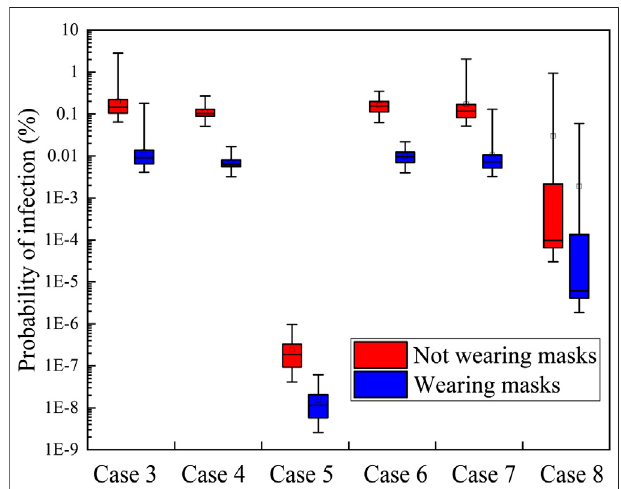
FIGURE 11 | Distribution of mass fraction of CO 2 in Plane 2: (A) Case 4; (B) Case 5; (C) Case 6; (D) Case 7; (E) Case 8.